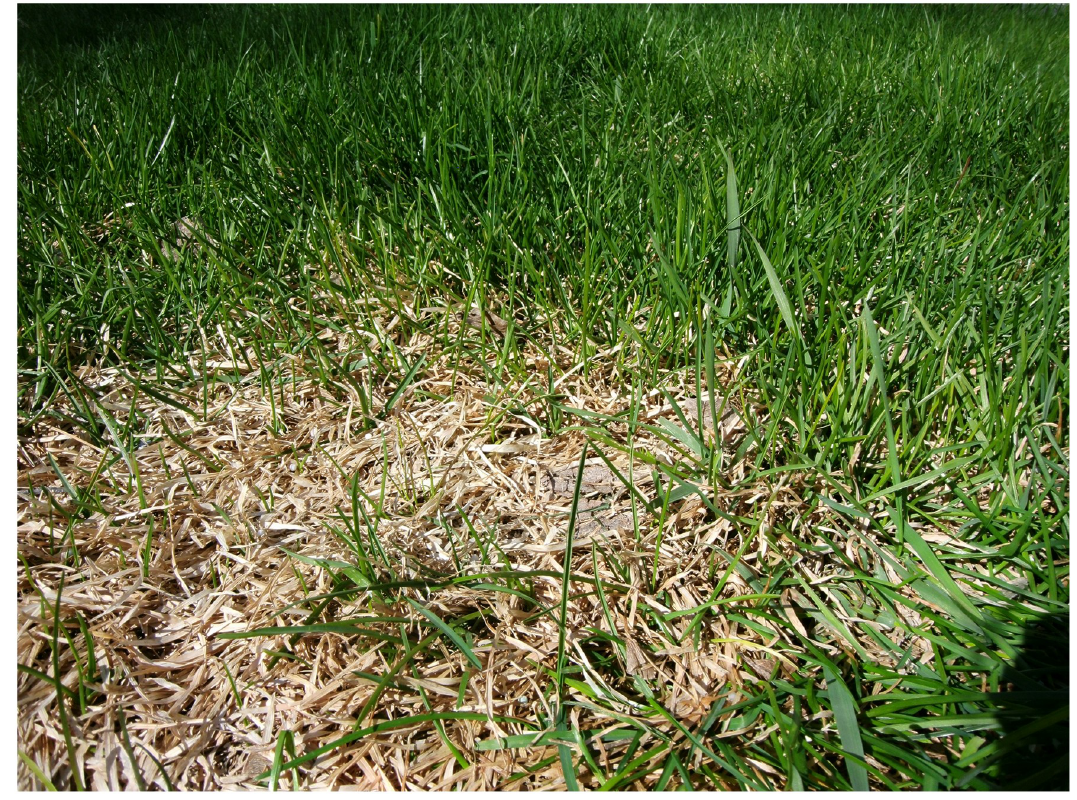
Fig 1. Feeling like dead